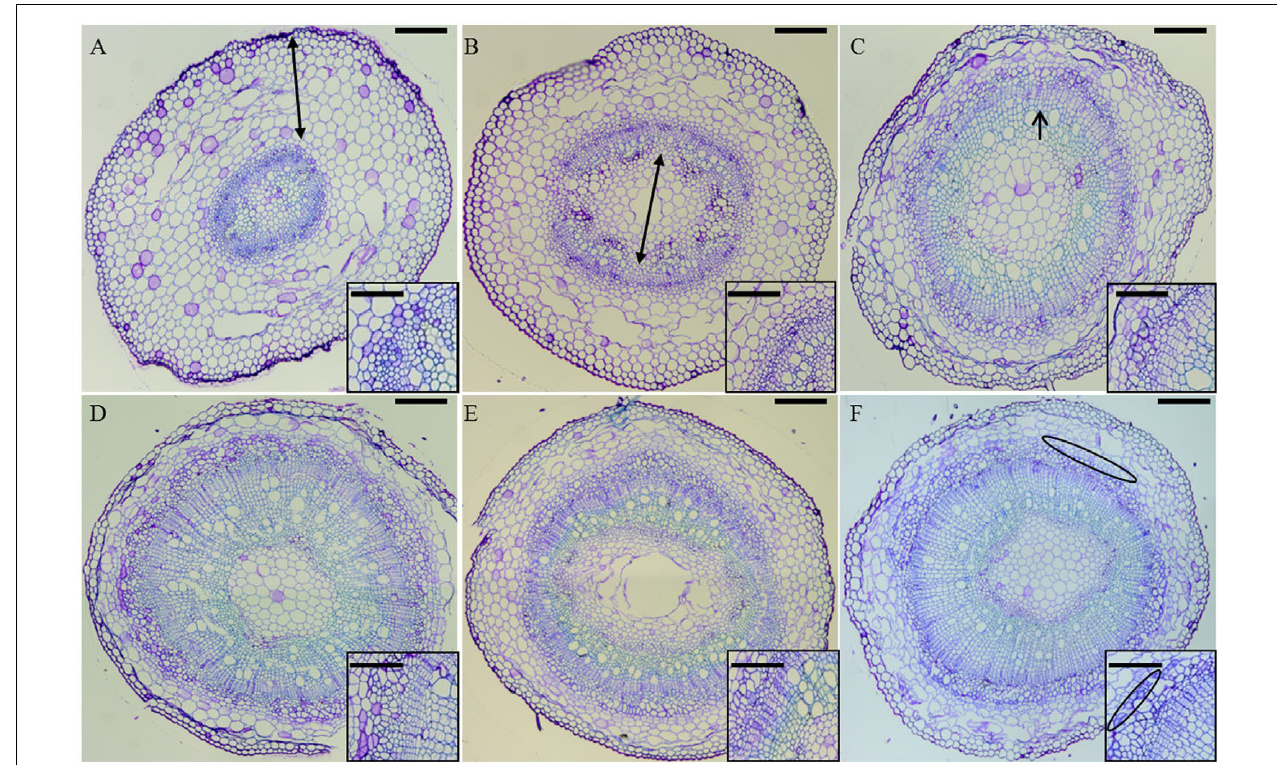
FIGURE 1 | Cross-sections of H6 ( A , top left), H9 ( B , top center), H12 ( C , top right), H15 ( D , bottom left), H17 ( E , bottom center), and H20 ( F , bottom right) stained with toluidine blue. In (A) , the double-pointed arrow spans the cortical parenchyma. In (B) , the double-pointed arrow spans the medullary parenchyma. In (C) , the arrow points to the developing xylem. In (F) , the phloem bast fibers are circled in black. Scale bar: 200 µ m in the main pictures, 50 µ m in the insets. The figure insets show zoomed regions of the hypocotyls where bast fibers gradually differentiate.